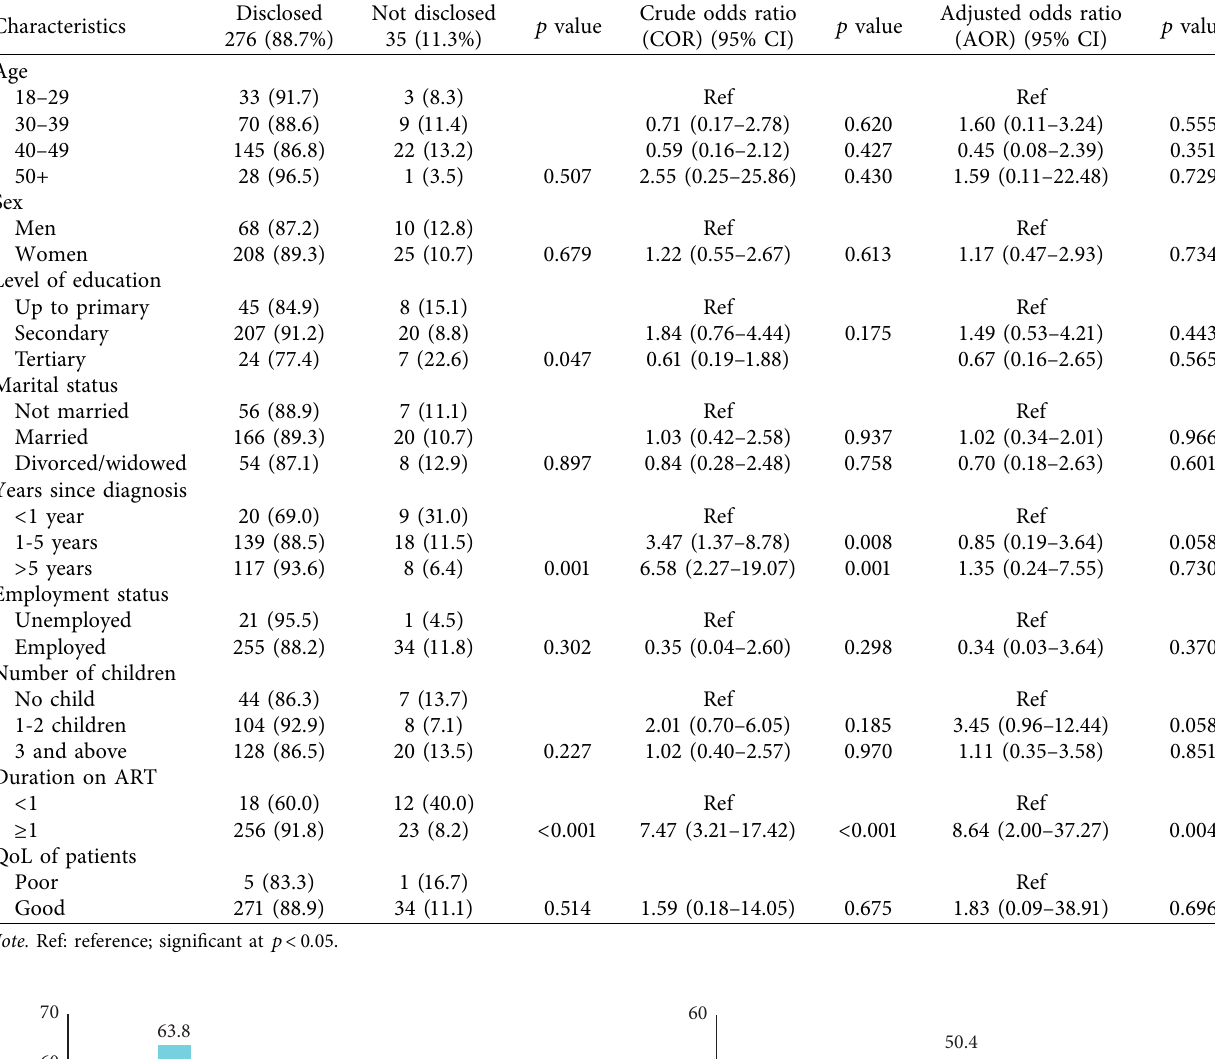
Table 2: Odds of HIV serostatus disclosure.